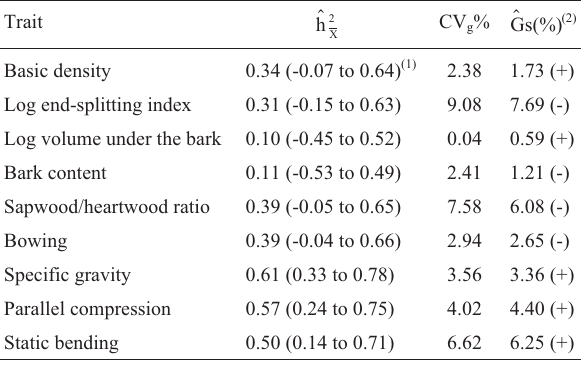
Table 3 - Estimates of heritability coefficients on a progeny mean basis $ ), genetic variation coefficients (CV g %), and expected response to (h X2 $ selection (Gs(%)) for nine traits evaluated in eight-year-old E. grandis .